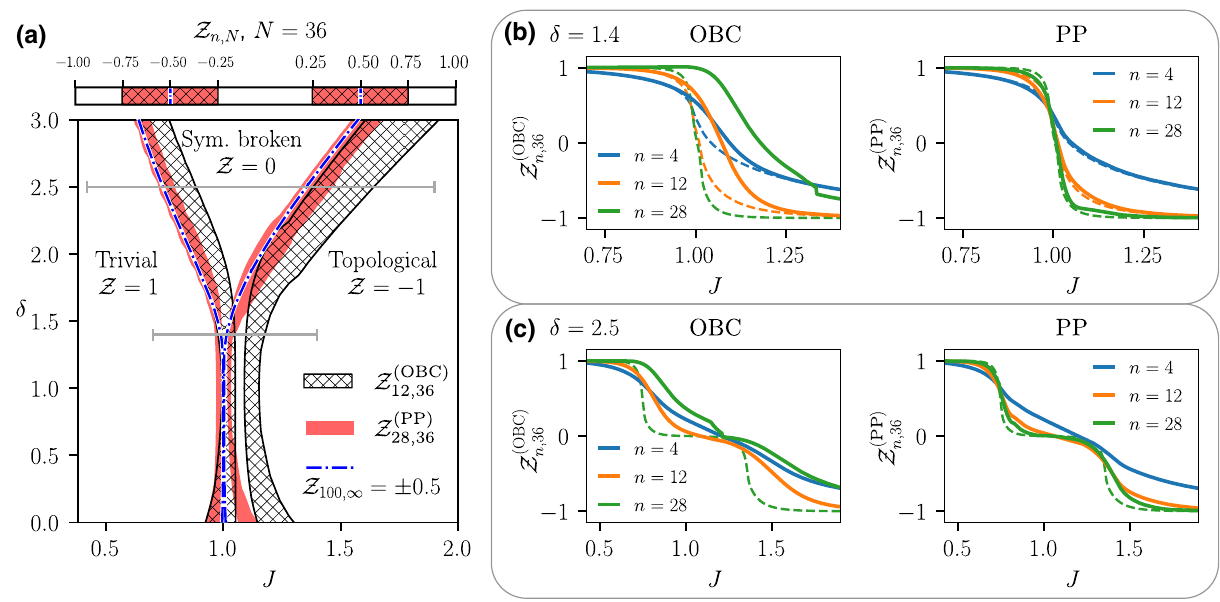
FIG. 2. Phase transitions in the extended SSH model [Eq. (5)] with N = 36 sites. (a) Phase diagram obtained using the partial reflection invariant Z n , N , [Eq. (6)]. We use the values − 0.5 and 0.5 to identify the phase transitions in the infinite system (dashed- dotted lines obtained for a subsystem of n = 100 sites) and the uncertainty intervals [ − 0.75, − 0.25] and [0.25, 0.75] for the finite systems. For the latter, the corresponding uncertainty regions on the phase diagram are shown as the hatched and continuously shaded and Z ( PP ) , respectively. The gray horizontal lines at δ = 1.4 and δ = 2.5 indicate the ranges of J detailed in (b),(c). areas for Z ( OBC ) n , N n , N (b) Dependencies of the Z n , N for the OBC GSs (left panel) and PP states (right panel) on J for δ = 1.4 and several values of n . The dashed lines show the target values for the subsystems of the infinite system with the same values of n . (c) The same as in (b) but for δ =